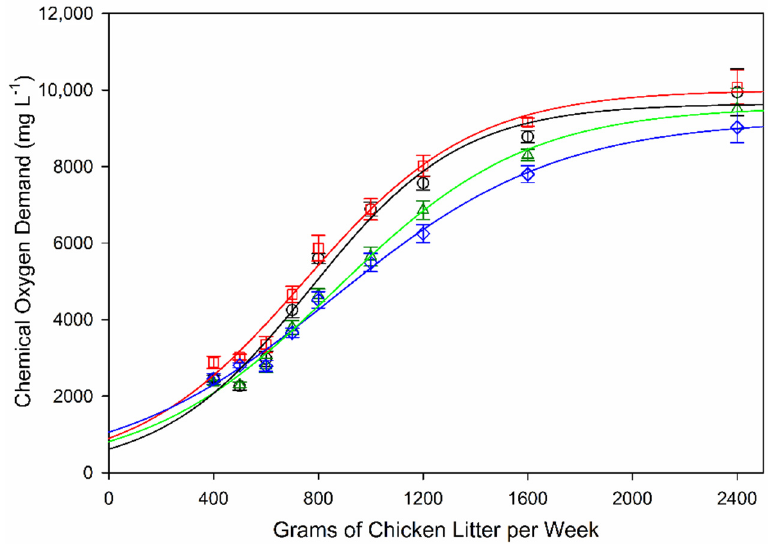
Figure 2. Chemical oxygen demand in digestate. Control: black circles, r 2 = 0.9426; digesters treated with sound: red squares, r 2 = 0.9384; digesters treated with microaeration, r 2 = 0.9475: blue diamonds; digesters treated with sound and microaeration: green triangles, r 2 = 0.9530.